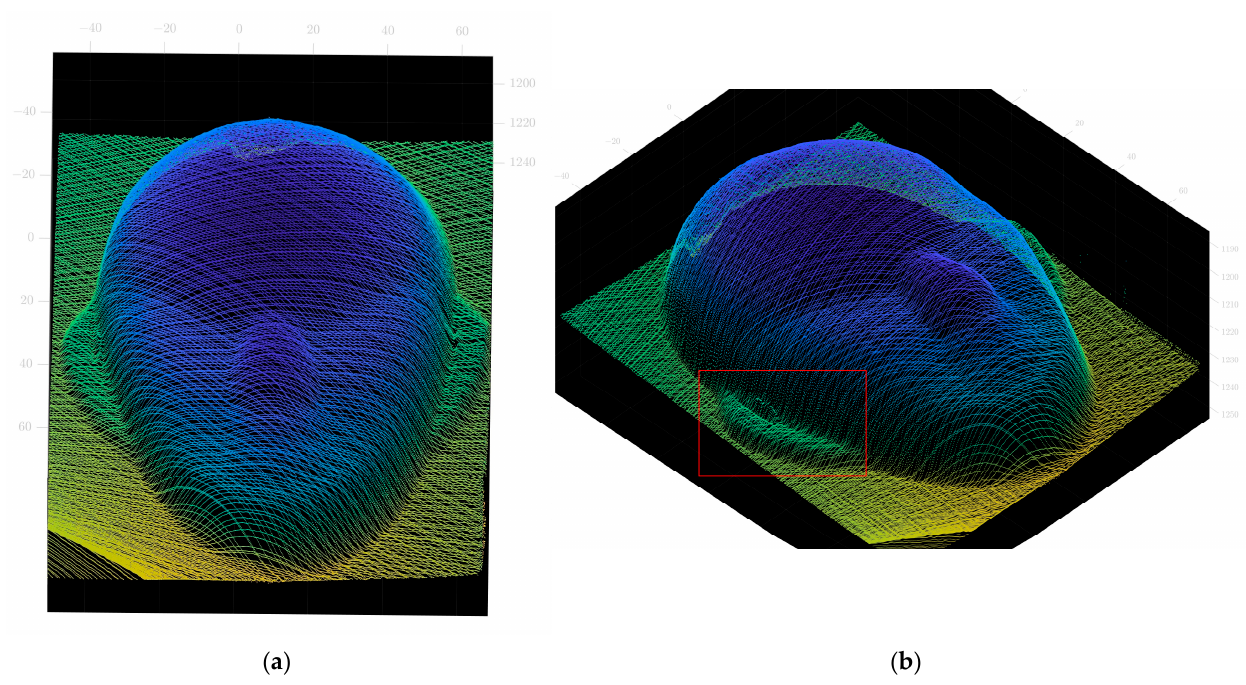
Figure 15. Point cloud image from this paper. ( a ) Point cloud image from frontal perspective ( b ) Point cloud image from the side perspective.